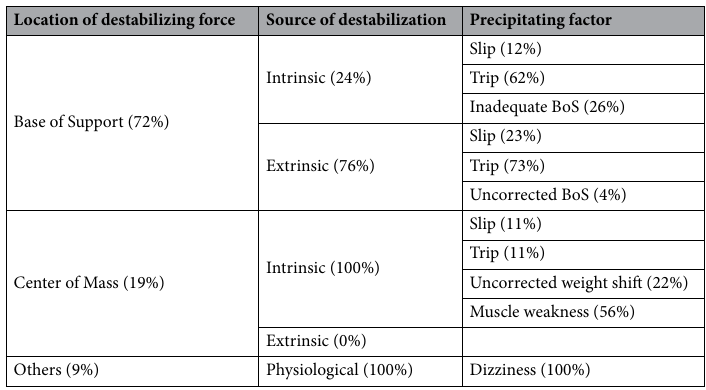
Location of destabilizing force Source of destabilization Precipitating